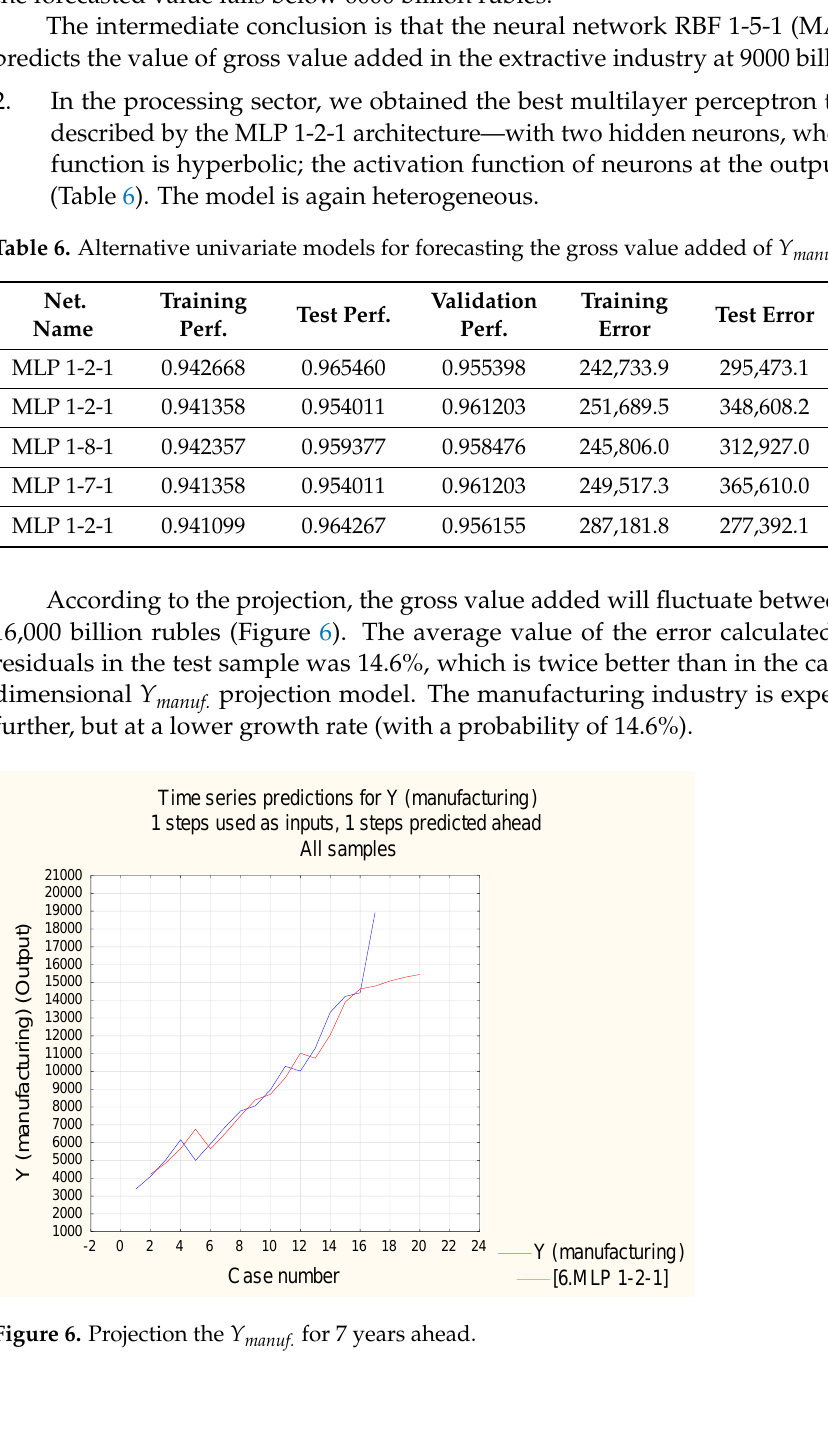
manuf. for 7 years